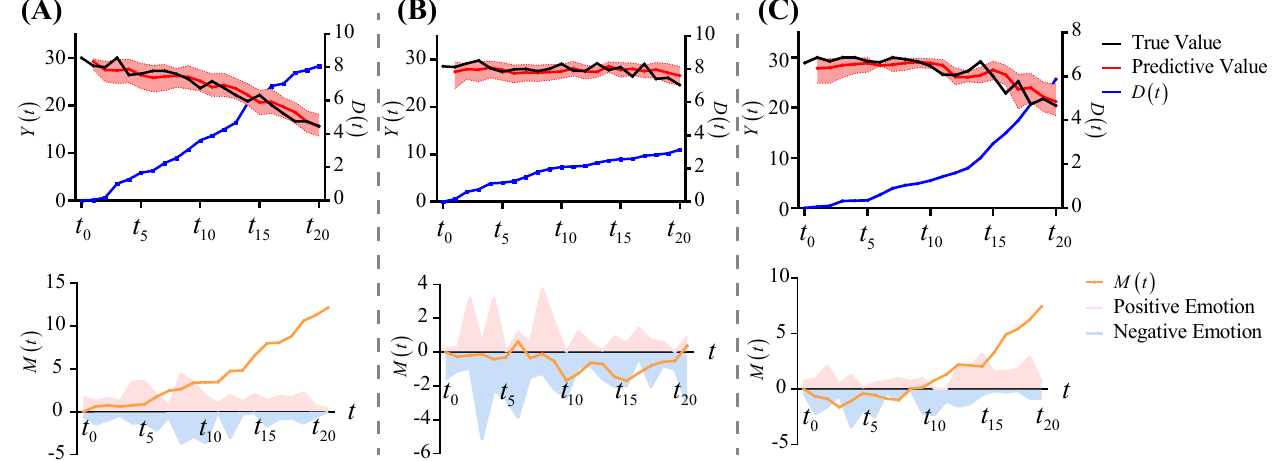
Figure 6. The prediction results under different emotional impacts. ( A ) Setting 3. ( B ) Setting 4. ( C ) Setting